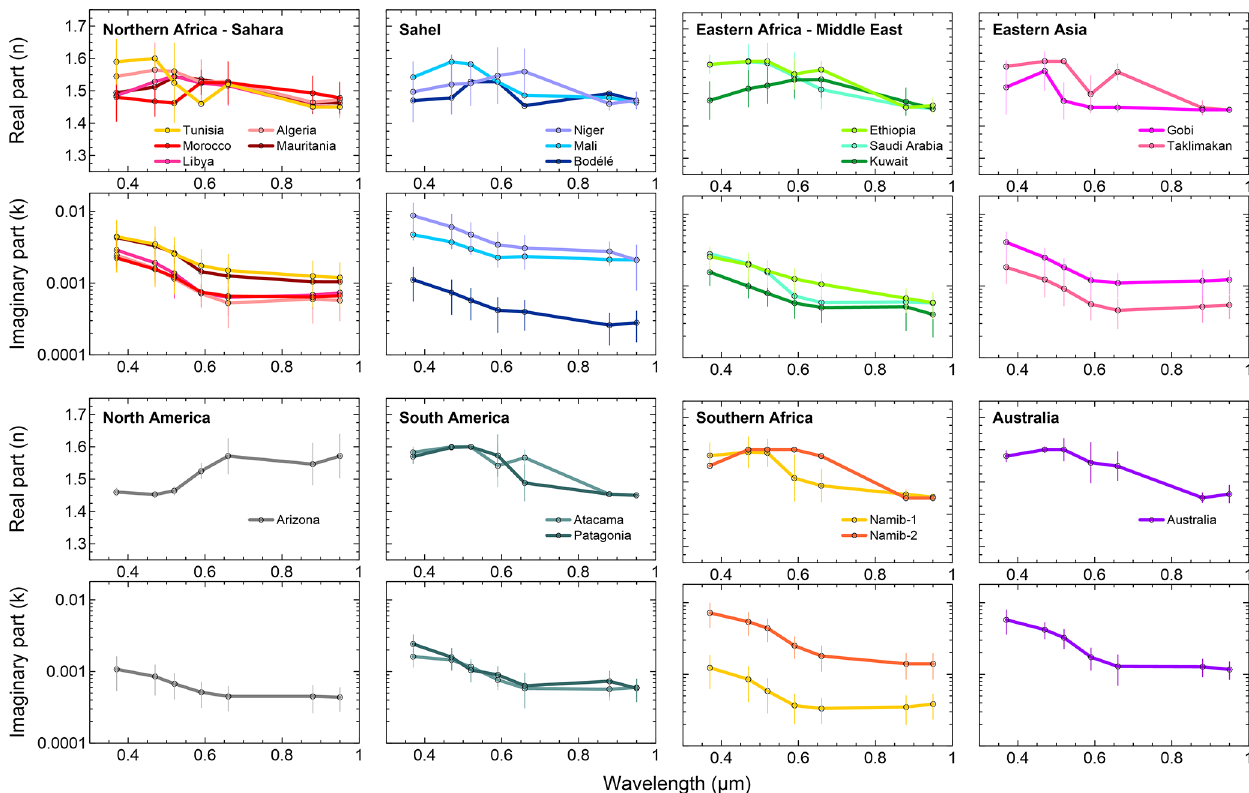
Figure 6. Real ( n ) and imaginary ( k ) parts of the dust complex refractive index at seven wavelengths between 370 and 950nm obtained for the 19 aerosol samples analyzed in this study. Data correspond to the time average of the 10min values obtained between the peak of the injection and 120min later. The error bar corresponds to the absolute uncertainty in n and k , estimated to be <8% for n and between 13 and 75 % for k